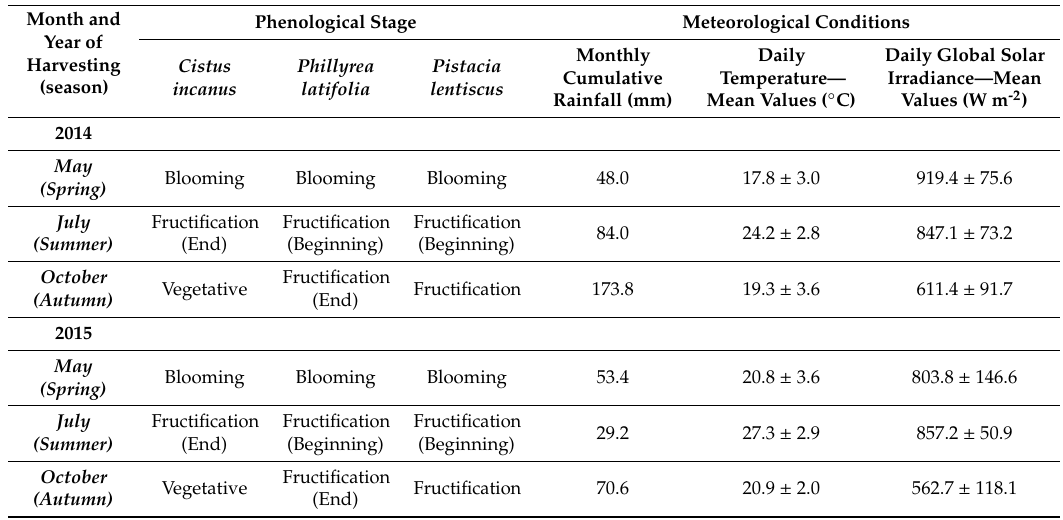
Table 3. Details of the phenological stages of the three studied species ( Cistus incanus , Phillyrea latifolia and Pistacia lentiscus ) and of the meteorological parameters during the harvesting